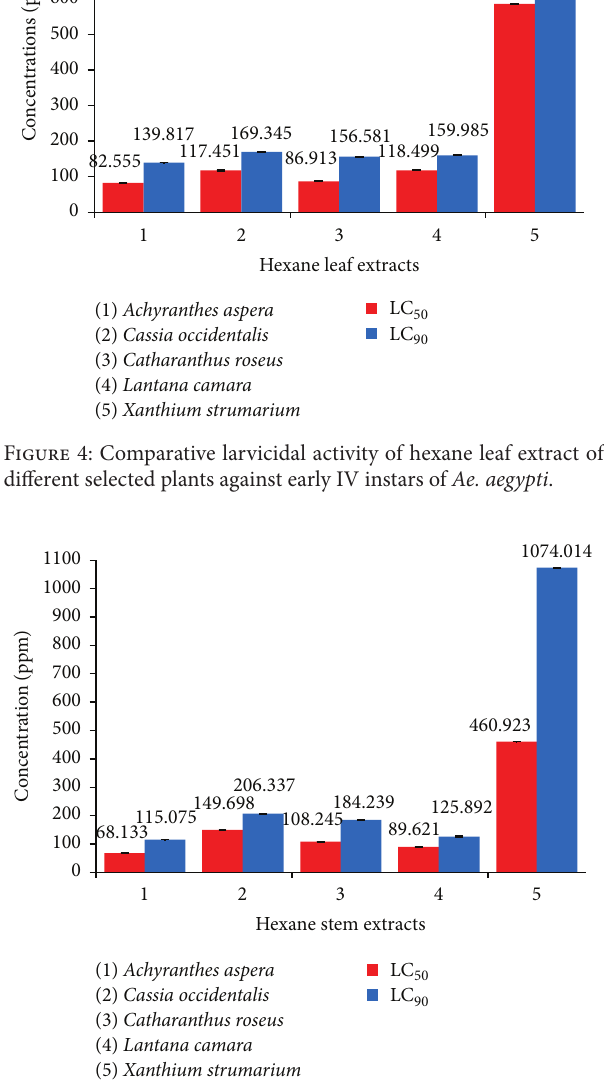
Figure 5: Comparative larvicidal activity of hexane stem extracts of different selected plants against early IV instars of Ae. aegypti